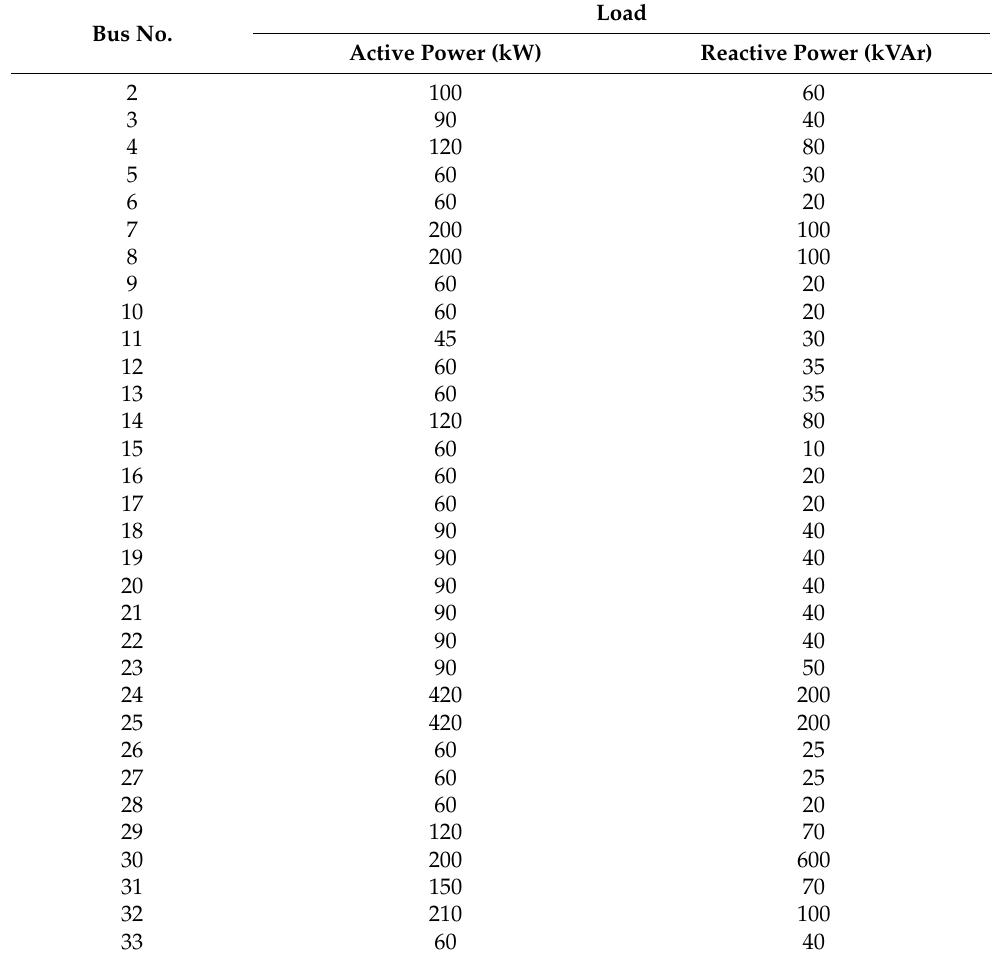
Table A3. Bus data of the IEEE 33-bus test distribution system. Bus